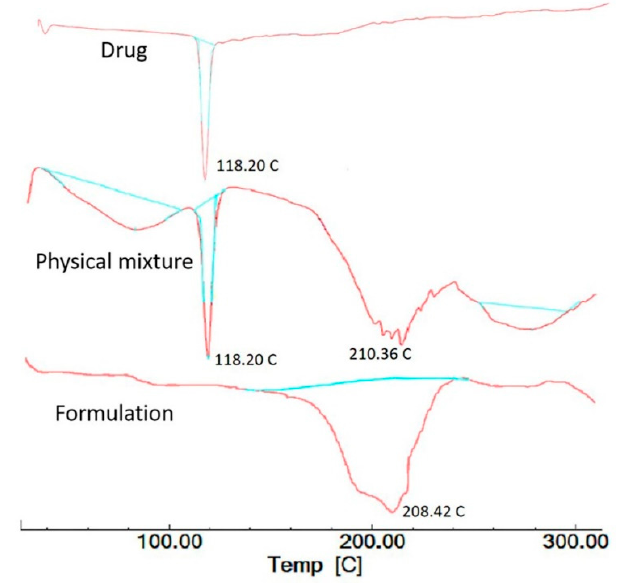
Figure 9. Differential scanning calorimetry patterns of rivastigmine tartrate, physical mixture, and optimized nanoparticle formulation (batch C1).